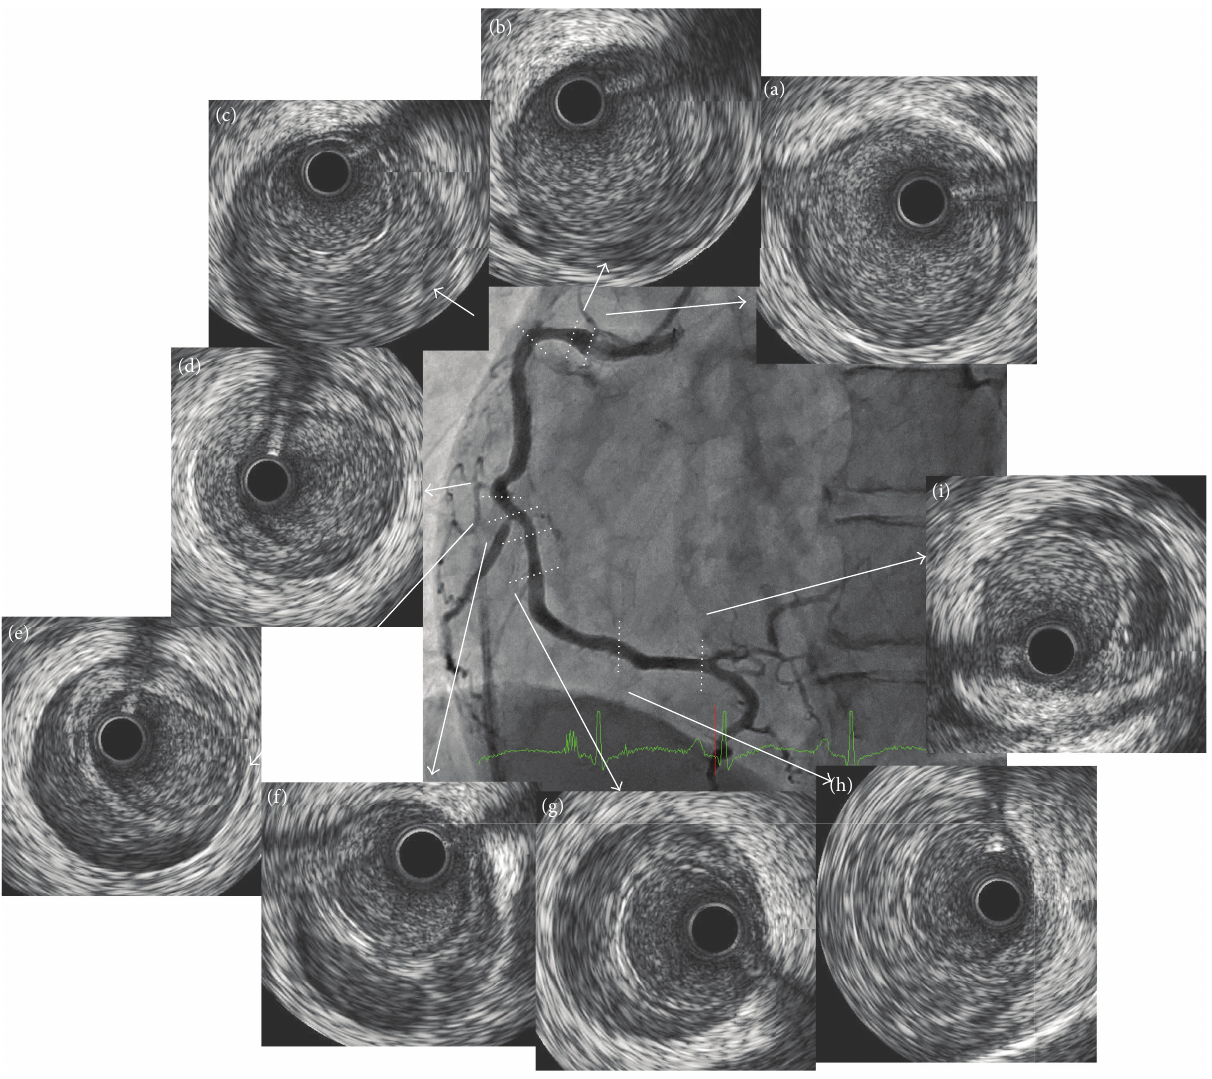
Figure 4: IVUS findings in the RCA 12 days after the onset of the MI. An intramural hematoma from the proximal to the distal RCA and double lumen were observed in spots (b–i). CAG: LAO